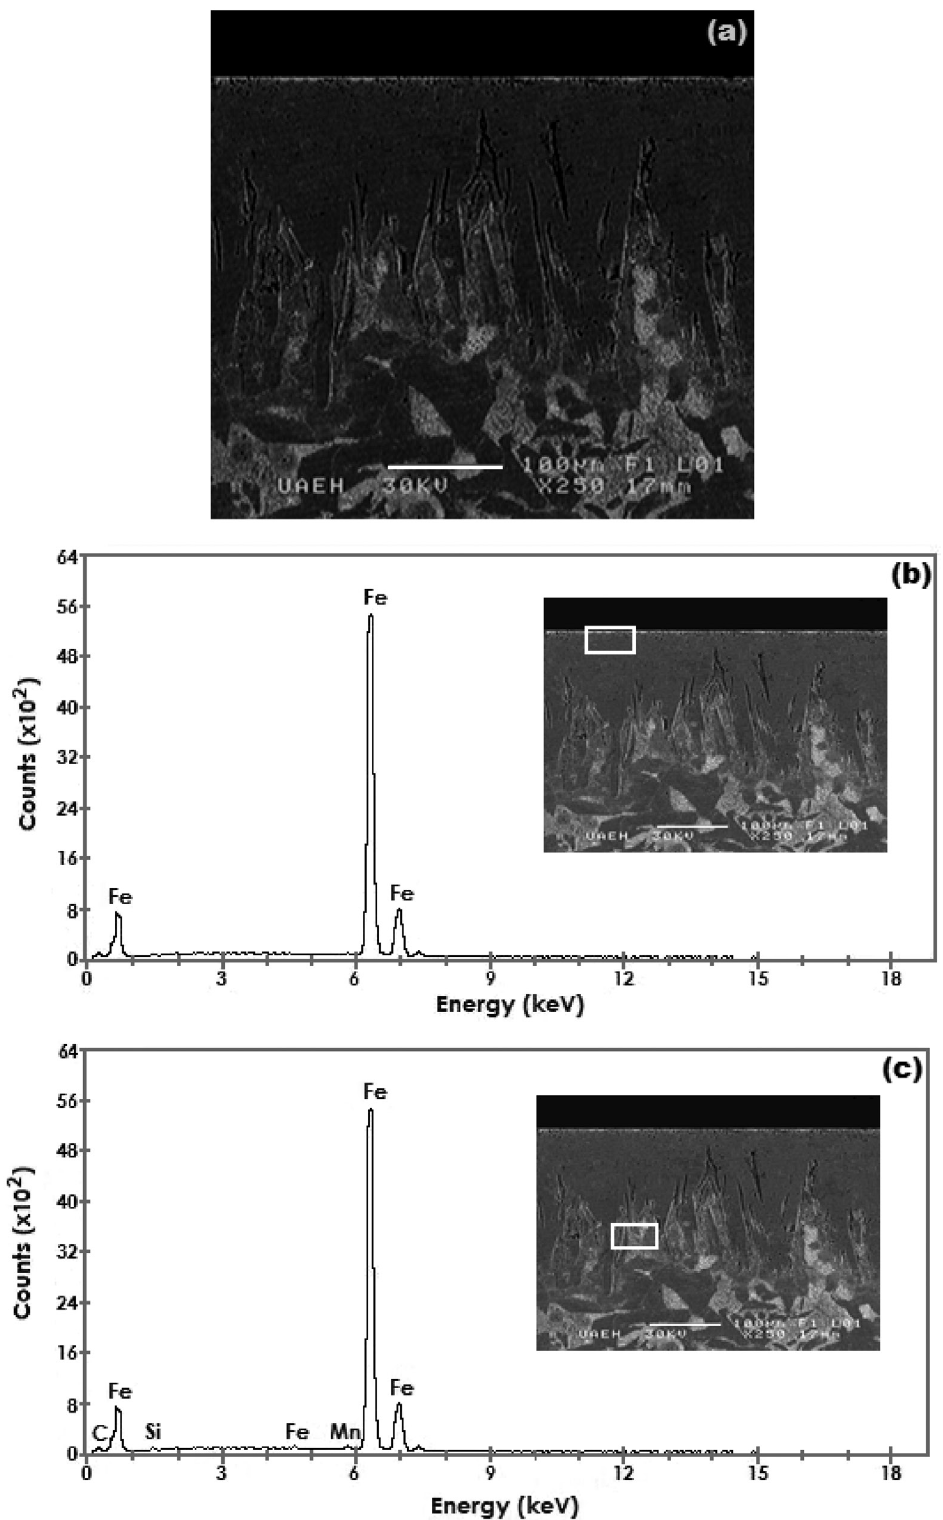
Fig. 5: (a) SEM micrograph of the cross-section of borided AISI 1026 steel at 1223 K for 8 h, (b) EDS spectrum obtained at the surface of borided sample and (c) EDS spectrum obtained at the (boride layer/substrate)